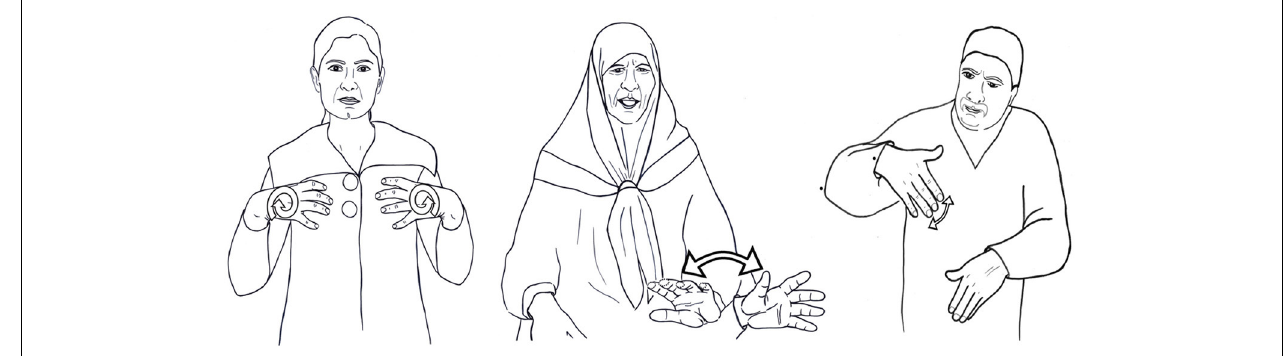
FIGURE 5 | The sign for sheep in ISL, KQSL, and